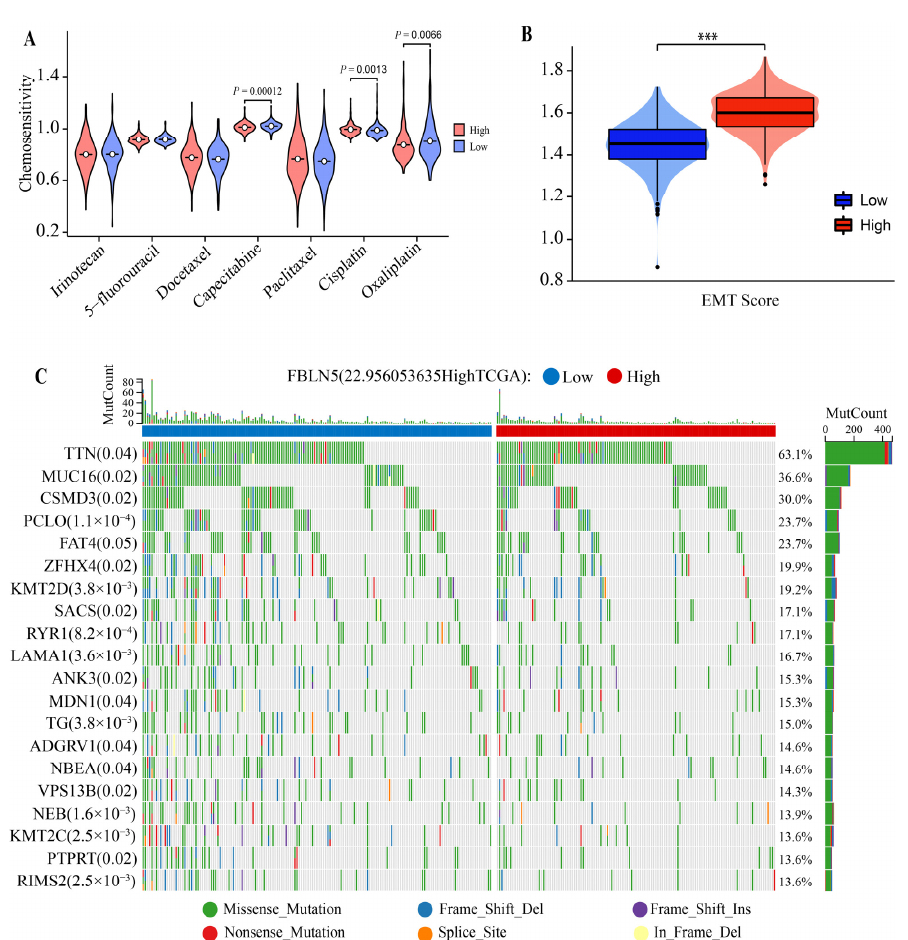
Figure 5. Relationships between FBLN5 and tumor progression. ( A ) Chemotherapy analysis based on FBLN5 expression levels. ( B ) EMT score. ( C ) Mutations in FBLN5 during the regulation of cancer progression. *** p < 0.001. Table 1. The values of FBLN5 to assess the sensitivity of immunotherapy checkpoints (TIDE).